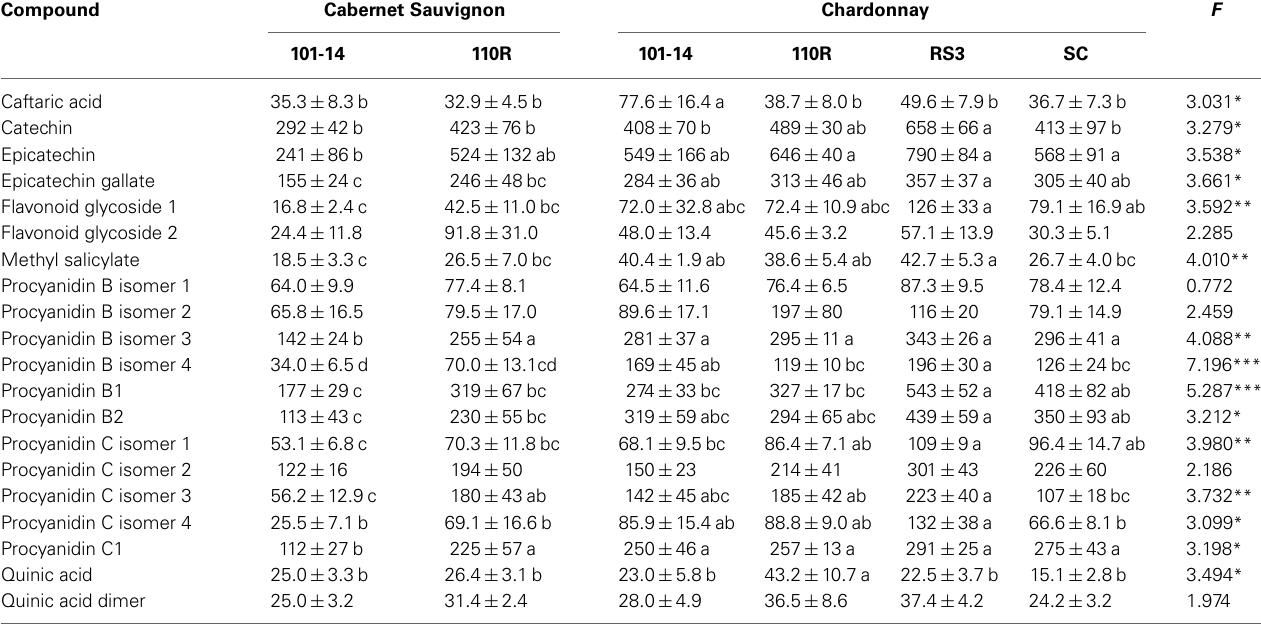
Table 3 | Mean ( ± SE) sap levels ( μ g/mL) of phenolic compounds from non-infected grapevines with different scion/rootstock